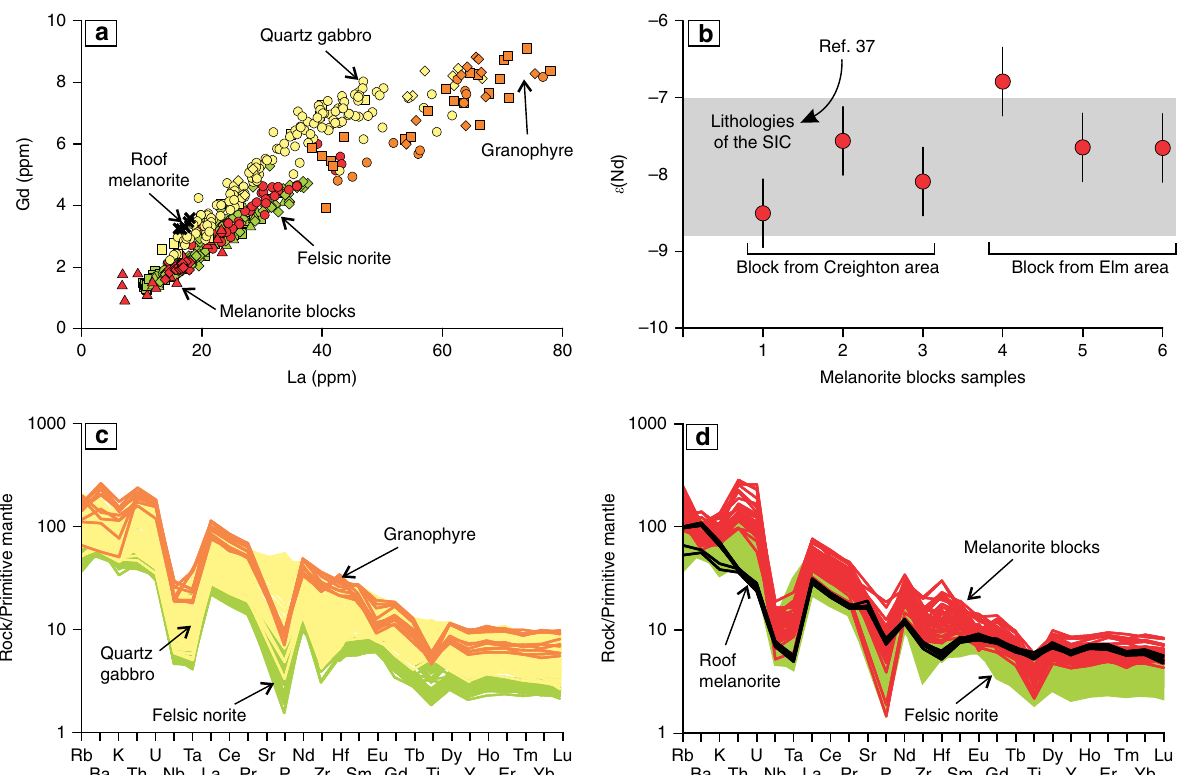
Rb BaK ThU NbTa LaCe PrSr PNd ZrHf SmEu GdTb TiDy YHo ErTm YbLu Fig. 7 Plots illustrating chemical and isotopic similarity of the melanorite blocks to rocks composing the SIC. a Whole-rock variation of La versus Gd for the Elm, Creighton and Lockerby traverses, South Range showing that the ratio of these incompatible elements in the melanorite bodies, including the roof one, is indistinguishable from all other rocks of the SIC. Representative data are located in Supplementary Data 1. b The initial ε Nd values in two melanorite bodies from Elm and Creighton areas are identical within error to those reported from all other intrusive rocks of the SIC 37 . The bars represent the standard error of the mean. Original Nd isotopic data are located in Supplementary Data 2. c Primitive mantle-normalized diagram showing similar patterns of trace element concentrations of felsic norite, quartz gabbro and granophyre of the SIC from the Elm traverse, South Range. Original data are located in Supplementary Data 1. d Primitive mantle-normalized diagram showing similar patterns of trace element concentrations of the melanorite blocks and norites of the SIC from the Elm travers, South Range. Also plotted are roof melanorite from the outcrop at the Creighton traverse, South Range (Fig.